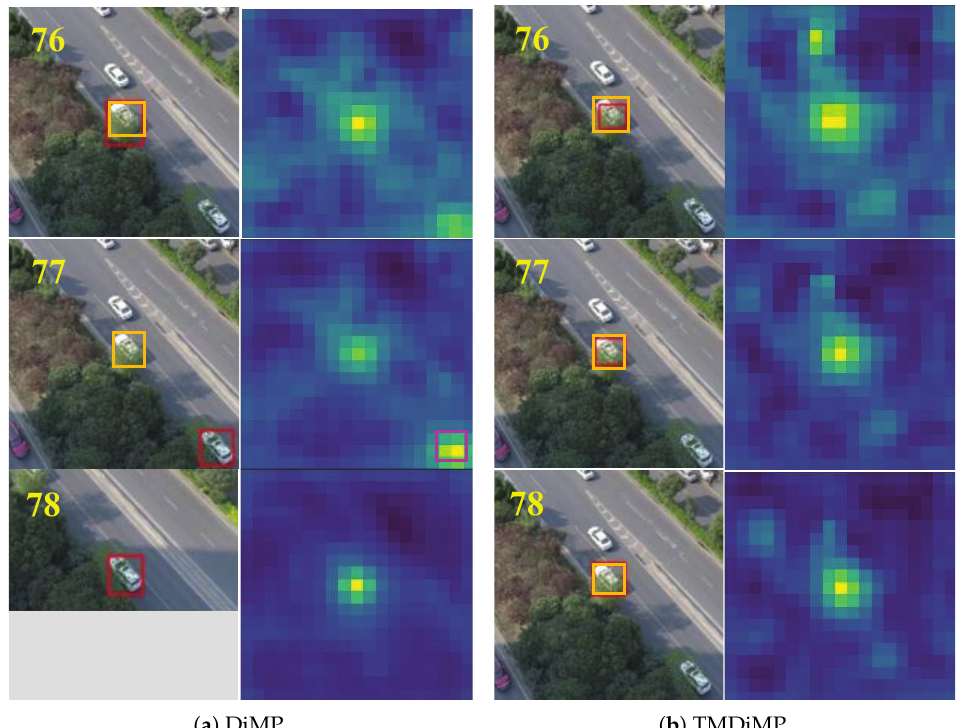
Figure 14. The score maps of DiMP and TMDiMP.